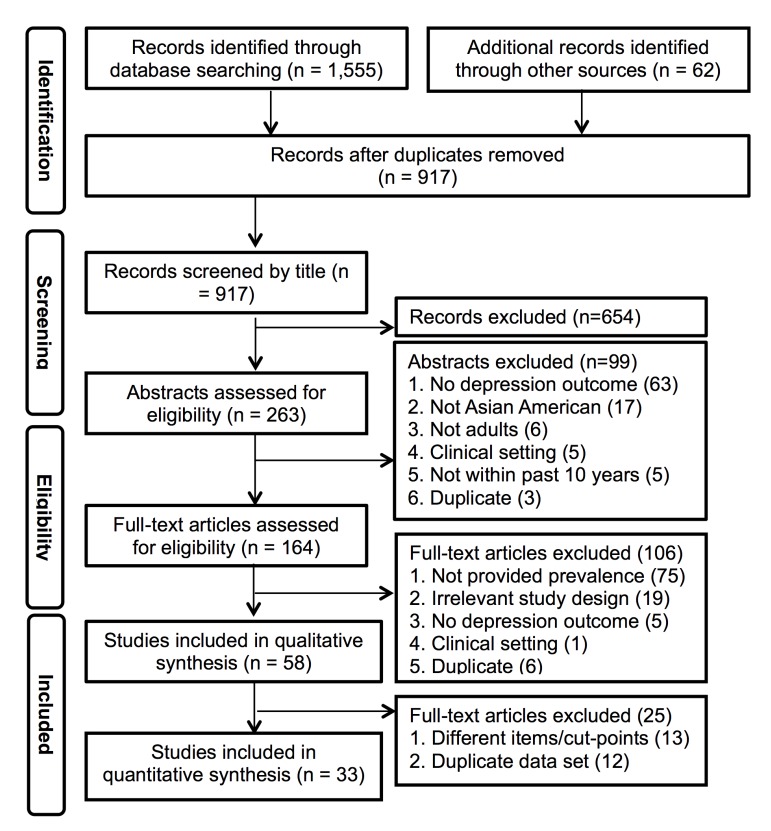
Flow diagram for review of studies of prevalence of depression in Asian Americans.